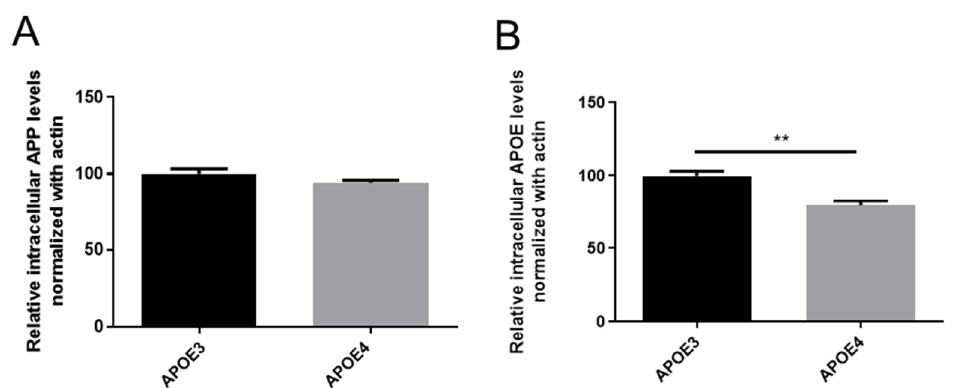
Figure 6. Effects of APOE genotype on intracellular levels of APP ( A ) and APOE ( B ). Primary cortical neurons cultures were obtained from P0-P1 newborn KI mice carrying the human APOE3 or APOE4 alleles. After 12 days in culture, APOE and APP levels were assessed in cell lysates using Western blot and normalization with actin levels. Statistics: Mann and Whitney test **: p < 0.01, comparison with APOE3, 3 independent cultures with 2 to 3 replicates per culture.